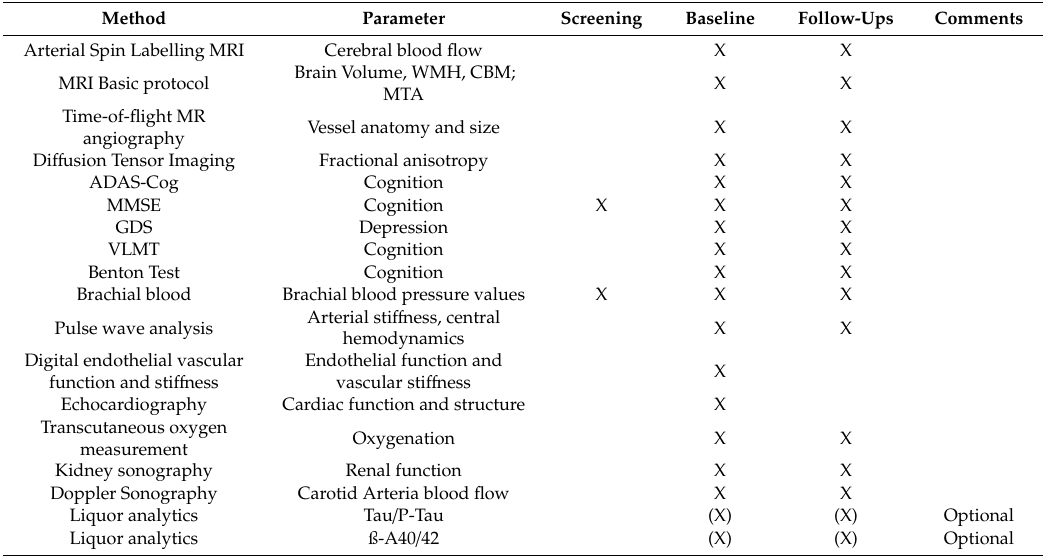
Table 2. Methods, main outcome parameters and time